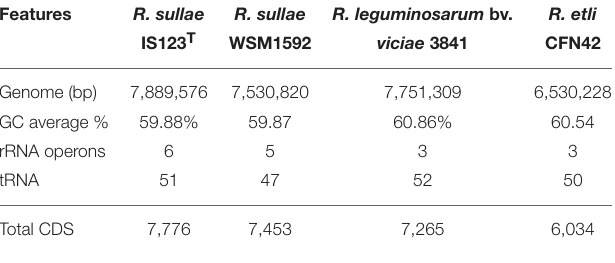
TABLE 1 | Comparative genome features of Rhizobium sullae IS123 T , its co-specific R. sullae WSM1592, and its two taxonomically closest relatives R. leguminosarum biovar viciae 3841 and R. etli CFN42.